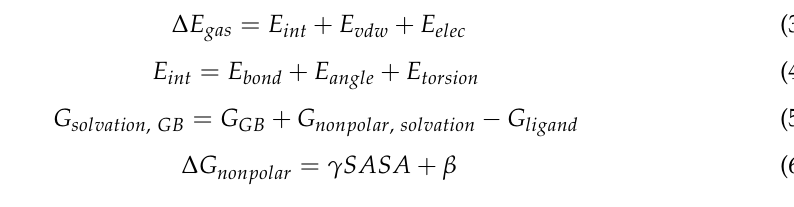
Figure S1: 3D interactions between compounds 1 – 14 and the native ligand with MPro (PDB ID: 6lu7), Figure S2: 3D interactions of the 14 library compounds in addition to the native ligand with spike glycoprotein (PDB ID: 6VYB), Figure S3: 3D interactions of the 14 library compounds plus the native ligand with nucleocapsid phosphoprotein (PDB ID: 6VYO), Figure S4: 3D interactions between